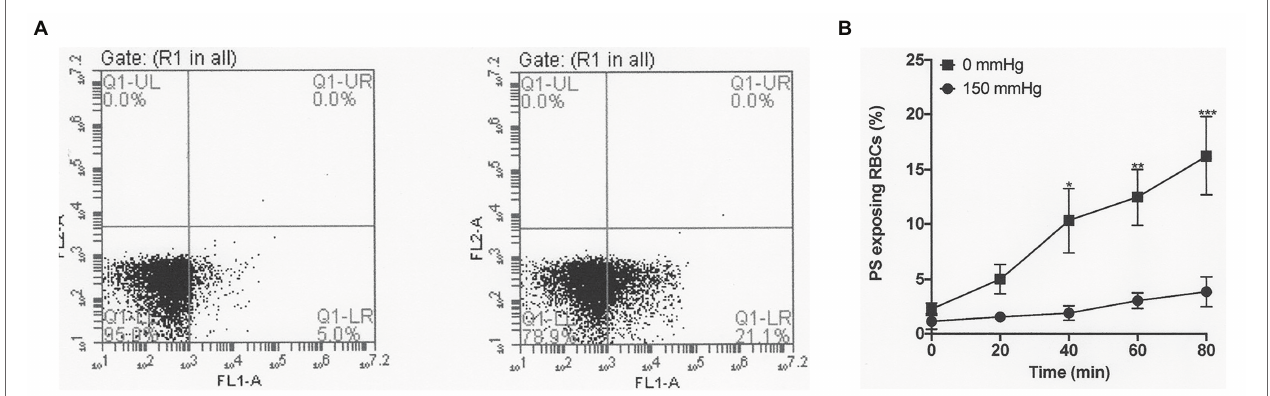
FIGURE 2 | The effect of oxygen tension on phosphatidylserine (PS) exposure in red cells from patients with SCA. Red cells (1% Hct) were incubated in Eschweiler tonometers at 37 ° C and pH 7.4 and an osmolality of 290 mOsm.kg −1 for up to 80 min under fully oxygenated (150 mmHg oxygen) or fully deoxygenated (0 mmHg oxygen) conditions. At the time intervals indicated, red cell aliquots were removed and PS exposure measured using fluorescently-labelled lactadherin (LA-FITC), as described in the Methods. (A) Representative FACS result from a single experiment after 80 min, in which PS positive red cells increased from 5.0% when incubated at 150 mmHg oxygen (left panel) to 21.1% at 0 (right panel). (B) Averaged data from three separate experiments. Symbols represent means ± SEM, n = 3. * p < 0.05; ** p < 0.01; and *** p <